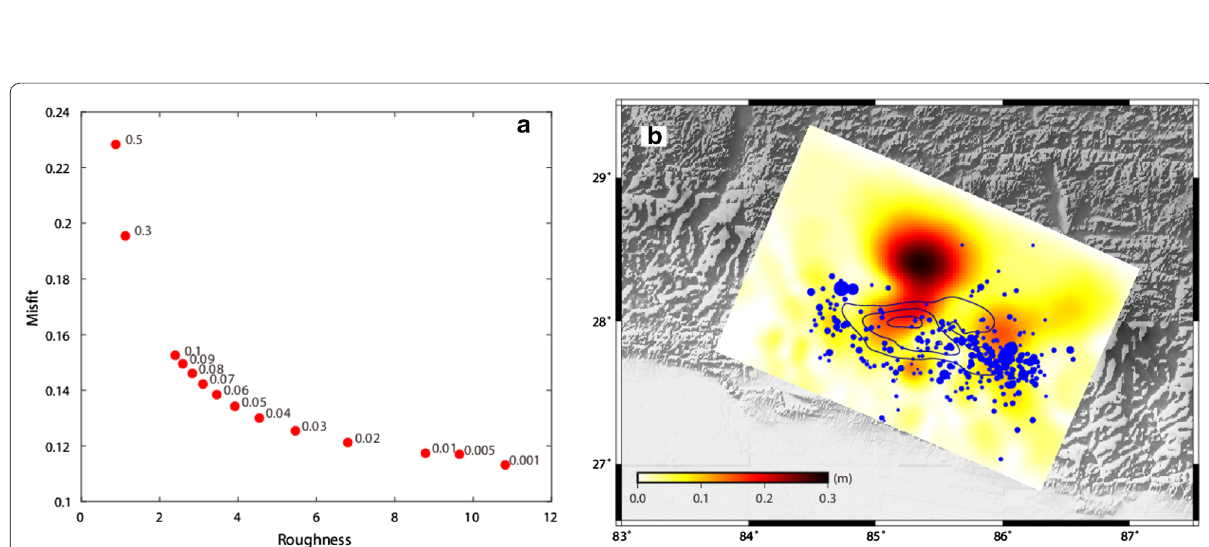
Fig. 5 a Trade-off curve between model roughness and misfit. Numbers indicate the smoothing factor β. b The inverted afterslip distribution. The color scale denotes the inverted afterslip distribution. The black contours denote the coseismic slip distribution on the fault. The blue circles denote the aftershocks after the Gorkha earthquake, and the size indicates the